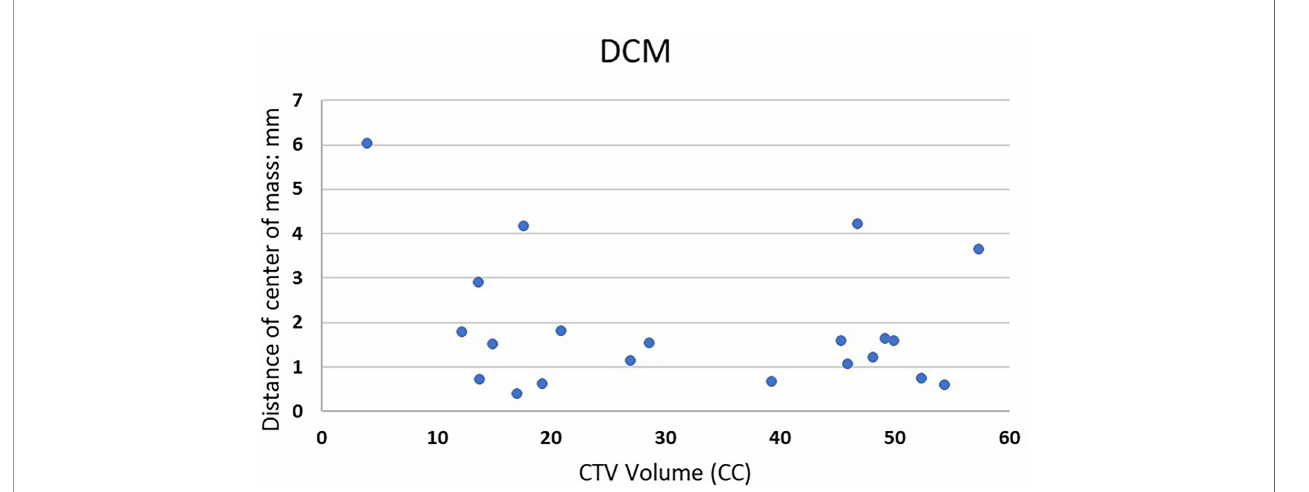
FIGURE 3 | Distance of center of mass of 21 lesions vs. clinically used CTV volume.